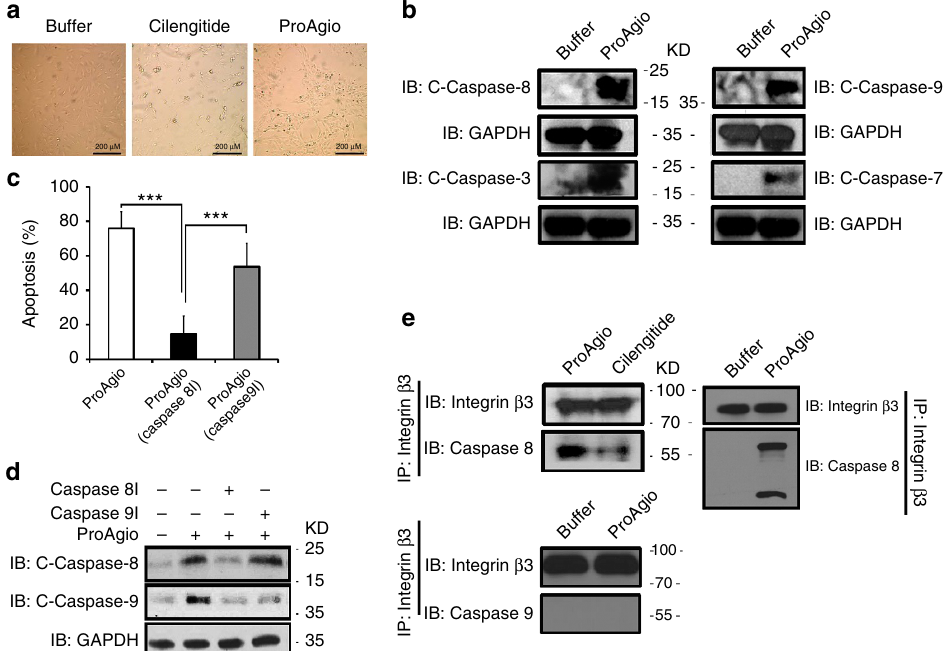
Figure 4 | ProAgio recruits and activates caspase 8 at cytoplasmic domain of integrin b 3 . ( a ) Representative phase contrast microscopic images of endothelial HUVEC cells that were treated by indicated agents for 8h. ( b ) Levels of indicated cleaved caspases (C-caspases) in HUVEC cell lysates were analysed by immunoblot using antibodies against various cleaved caspases. The cells were treated by 5 m M ProAgio for 10h. ( c ) Apoptosis of HUVEC cells that were treated by 5 m M ProAgio in the presence of caspase 8/9 inhibitors was analysed by apoptosis kit. Apoptosis was presented as % Apoptosis by defining the cells that were untreated as 0%. Error bars are standard deviations from measurement of five independent experiments. ( d ) Levels of cleaved casapases 8/9 (C-caspase 8/9) in HUVEC cell lysates were analysed by immunoblot using antibody against cleaved caspase 8/9. The cells were treated with 5 m M ProAgio and caspase 8/9 inhibitor for 5h. ( e ) Co-immunoprecipitations of caspase 8 (Upper) and caspase 9 (Bottom) with integrin b 3 (IP:integrin b 3 ) were analysed by immunoblots (IB:caspase 8/9). The cells were treated by the indicated agents 5h before the preparation of extracts. Immunoblot of integrin b 3 (IB:integrin b 3 ) indicates amount of b 3 was precipitated down in the co-IPs. Immunoblot of GAPDH (IB:GAPDH) in b and d